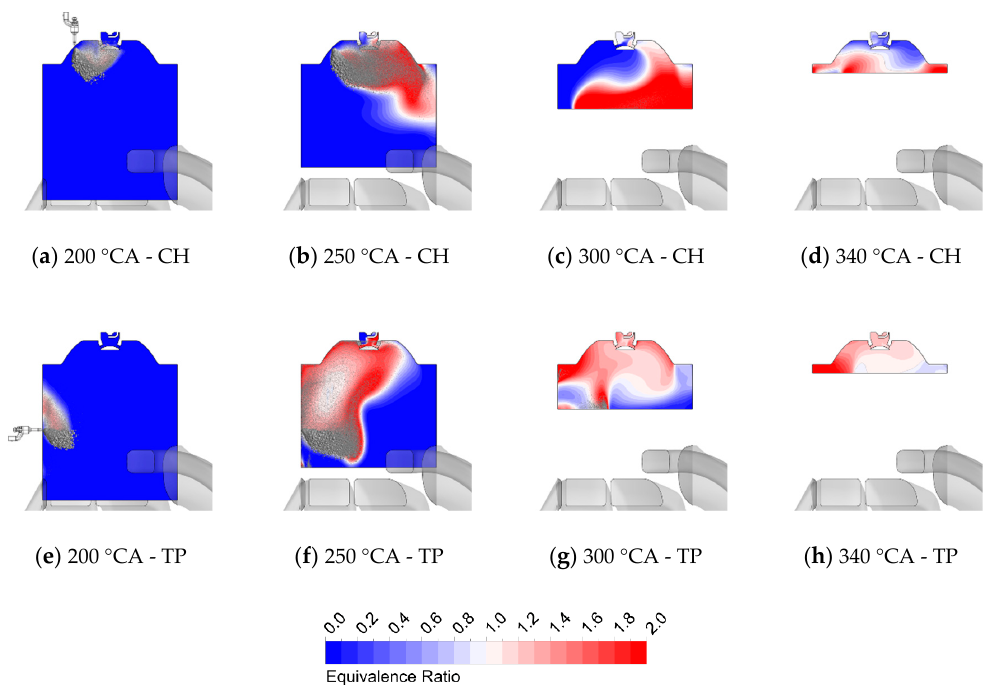
Figure 15. Spray behavior and equivalence ratio contours at 7500 rpm and full load with PN6 prechamber for both injection strategies.